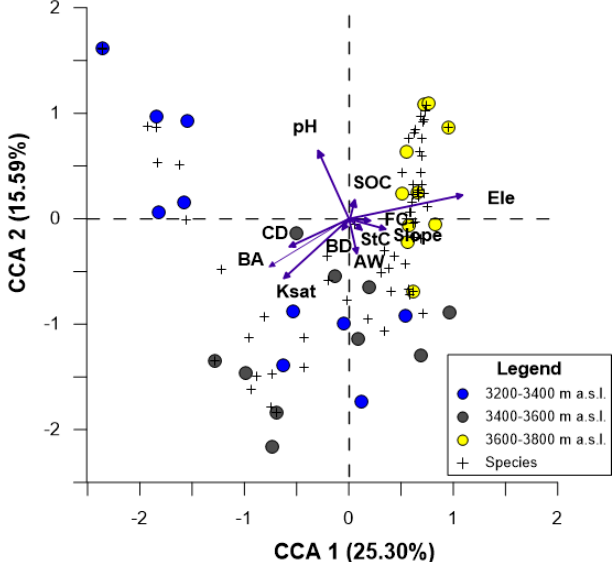
Figure 6. Canonical Correspondence Analysis (CCA) showing ordination of herbaceous species richness and their plant cover (+), plot (circles), and attributes of pine plantation and their physical and chemical soil characteristics across an elevational range (arrows). Abbreviations are as follows: CD = canopy density, BA = basal area, Ksat = saturated hydraulic conductivity, SOC = soil organic carbon, StC = water content at saturation point, FC = water content at field capacity, AW = available water capacity, pH = potential hydrogen, Ele = elevation, BD = bulk density.